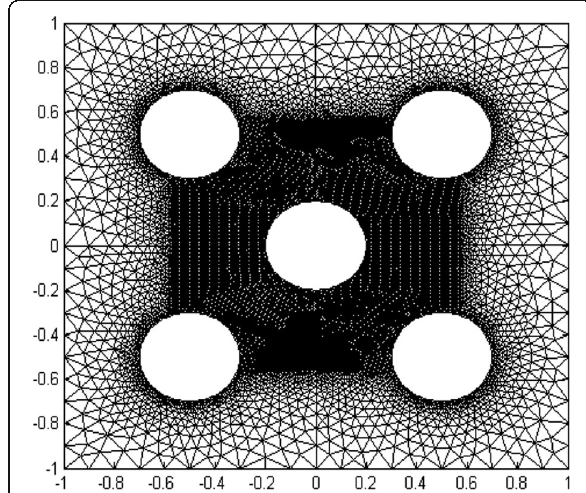
Fig. 7 Mesh using four sub-domains for cylinder